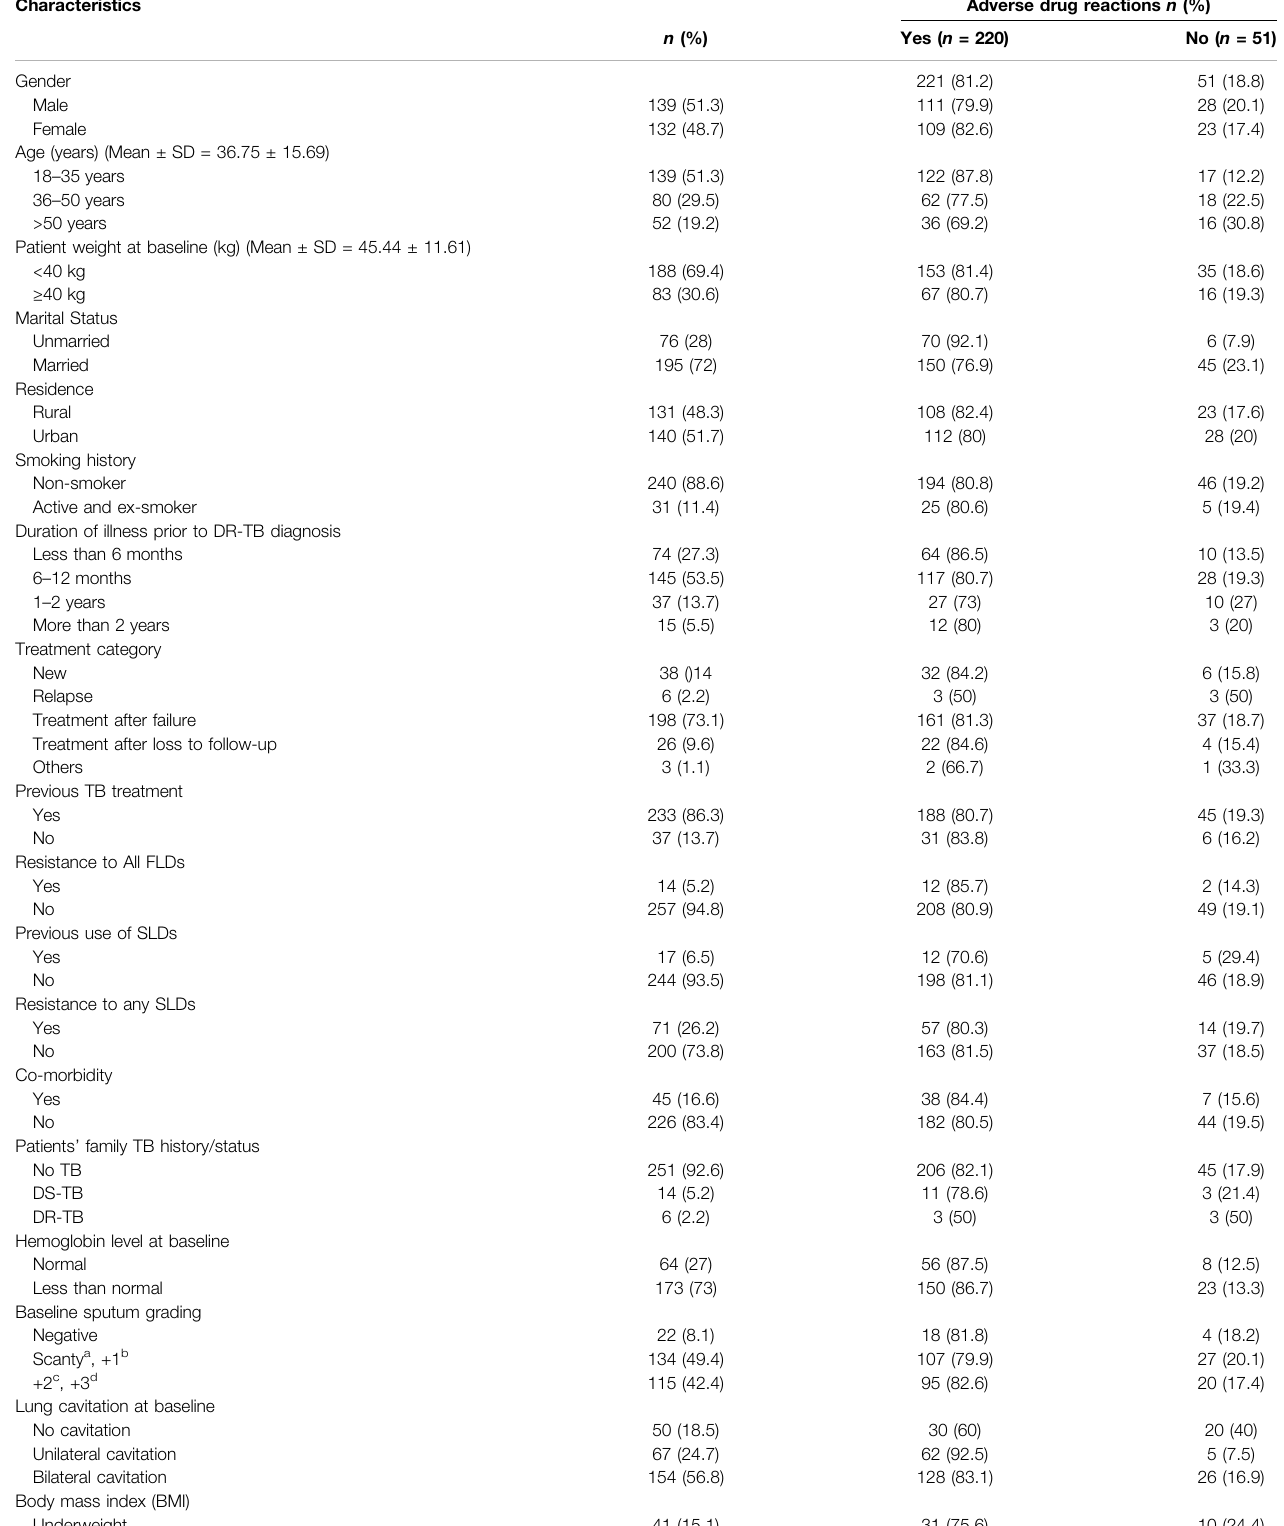
TABLE 3 | Patients ’ characteristics and frequency of